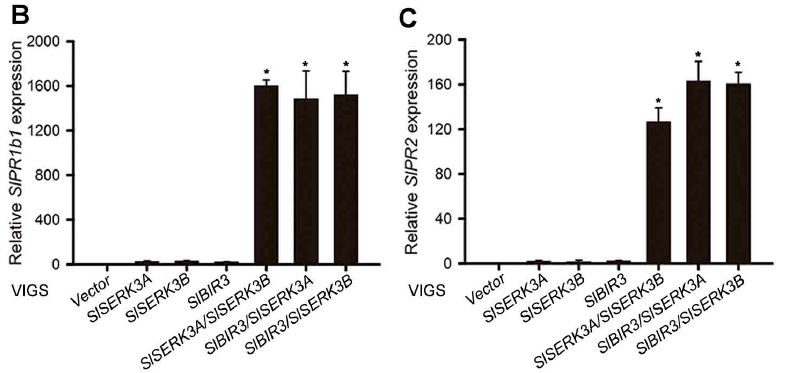
Figure 7. Co-silencing of SlBIR3 and SlSERK3 triggers cell death. ( A ) Phenotypes of individually silenced SlSERK3A , SlSERK3B and SlBIR3 plant leaves and co-silenced SlSERK3A / SlSERK3B , SlBIR3 / SlSERK3A and SlBIR3 / SlSERK3B plant leaves (upper panel). The lower panel shows trypan blue staining of leaves corresponding to the upper panel. ( B , C ) The relative transcript levels of pathogenesis related genes, SlPR1b1 and SlPR2 , in leaves showed in ( A ), measured by real-time qRT-PCR, with SlUBI3 used as the reference gene. The asterisks indicate significant differences compared to the control (VIGS-Vector) according to a Student’s t test (* p < 0.05). Experiments were performed three times with similar results.